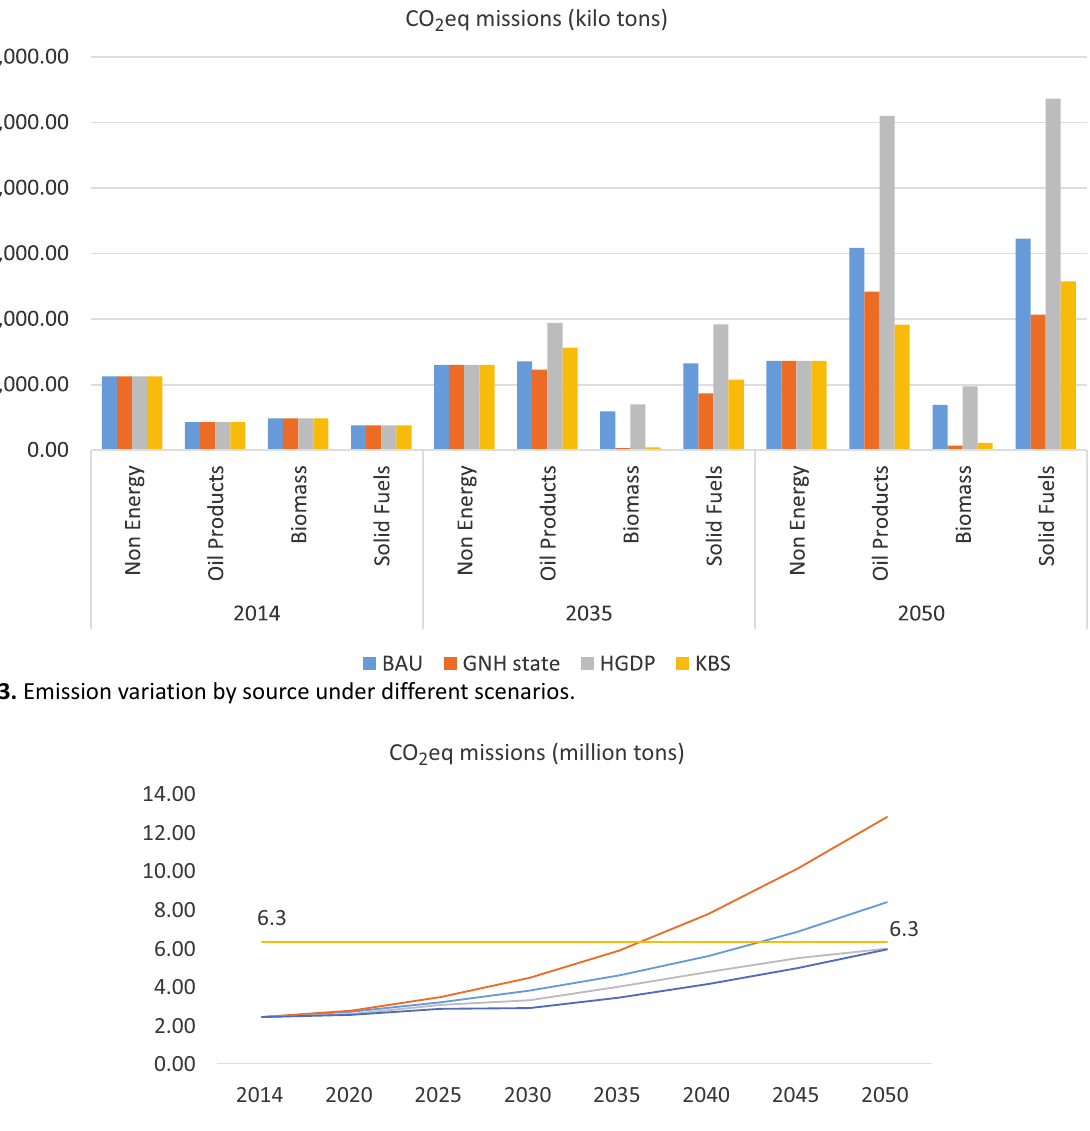
Figure 4. Scenario based CO